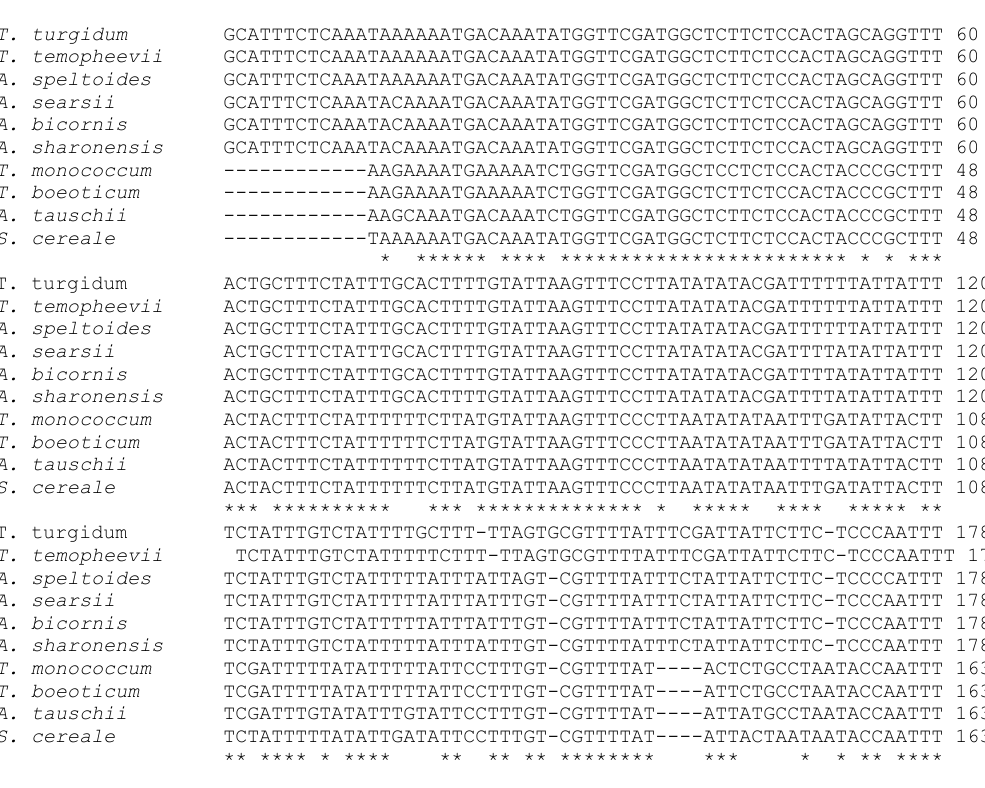
Figure 3. Multiple alignment of 500 bp of orf256 of Triticum and Aegilops